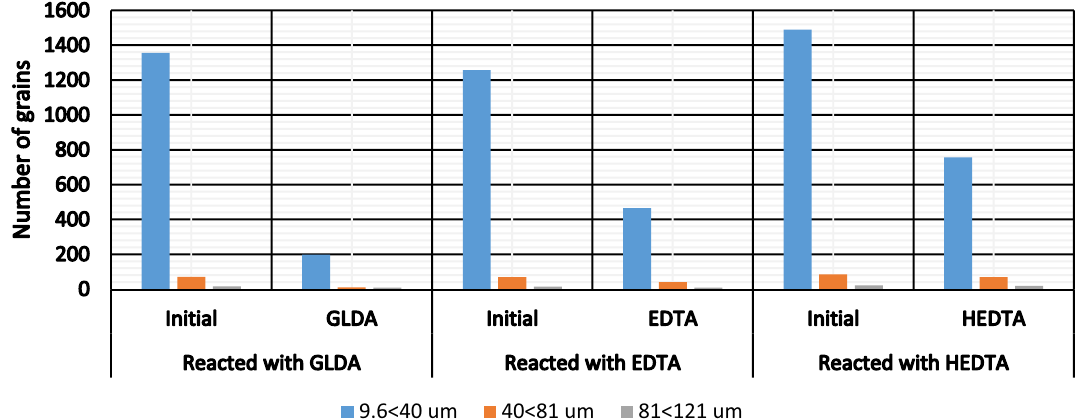
Fig. 15 The grain size distribution of Rutile in Berea Sandstone before and after reaction with chelating